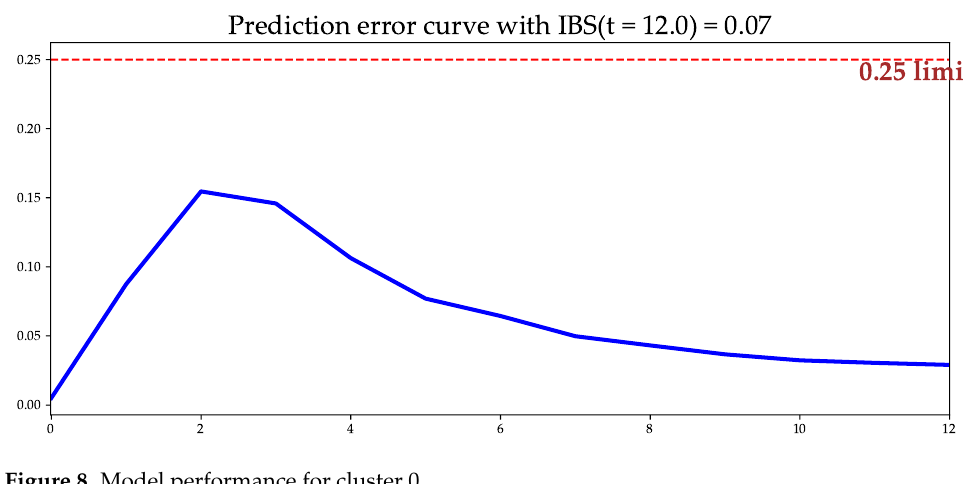
Figure 7. Elbow analysis.